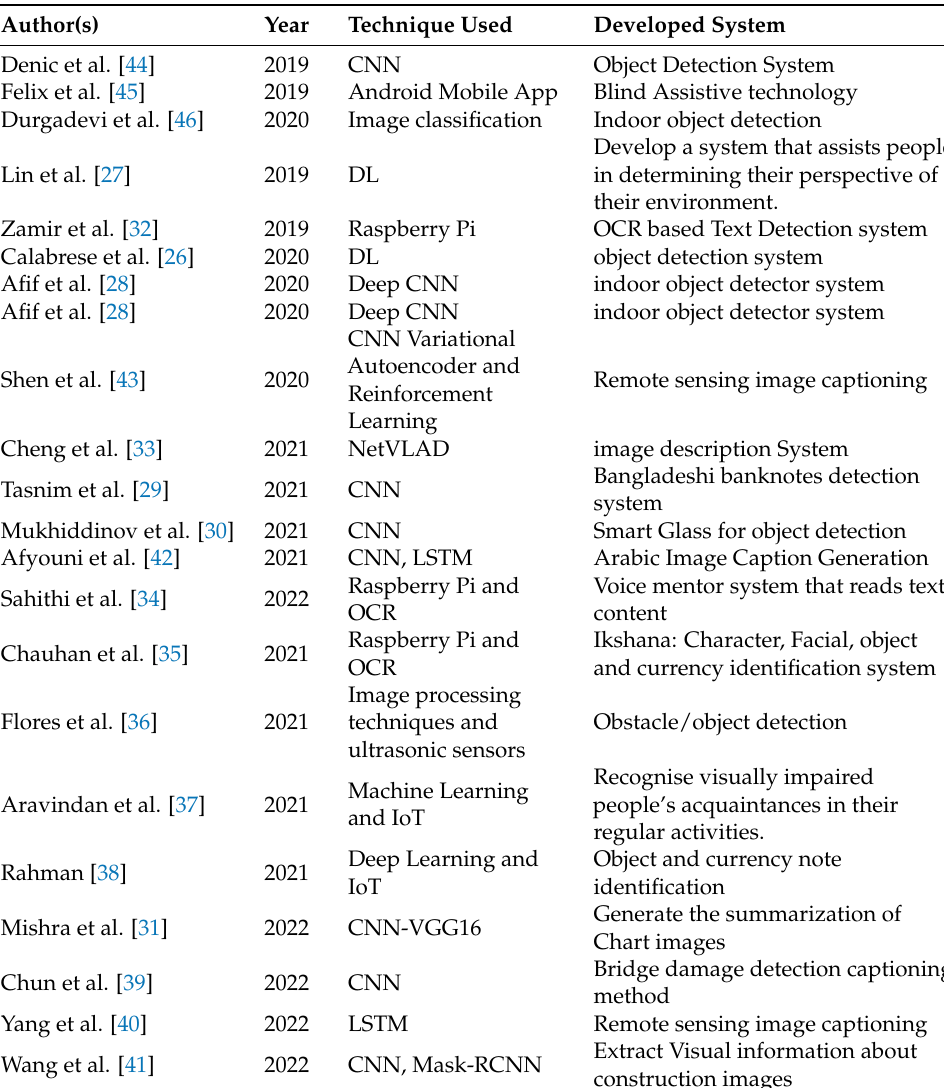
Table 1. Summarization of the Related